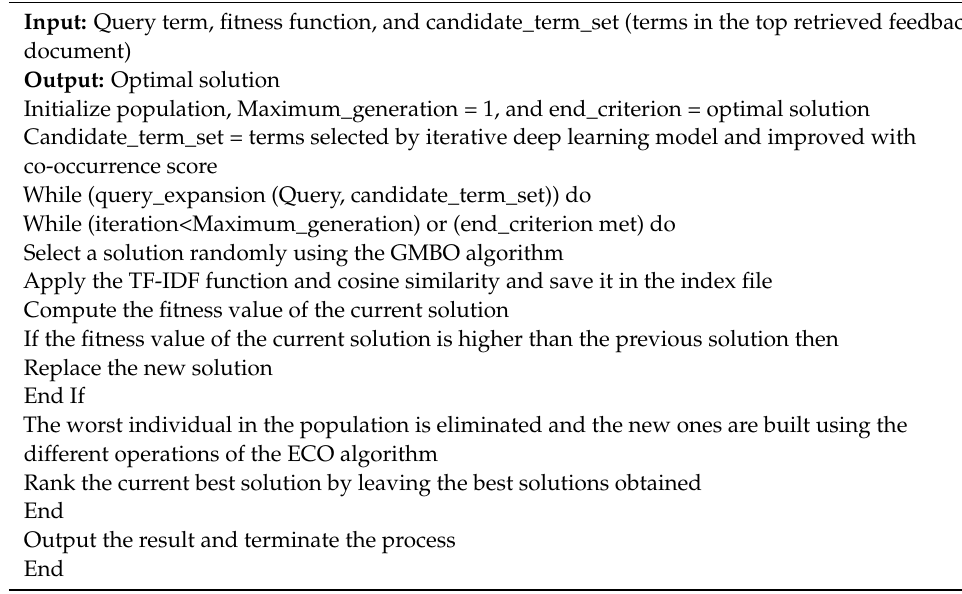
Algorithm 1: Pseudocode of the hybrid GMBO-ECO algorithm.